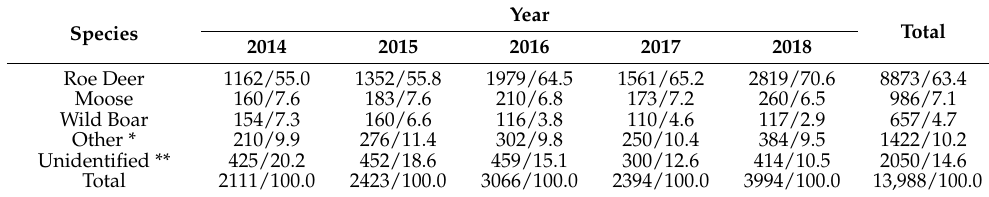
Table 1. Structure of dataset on WVCs (number/percent of accidents) used for analysis.